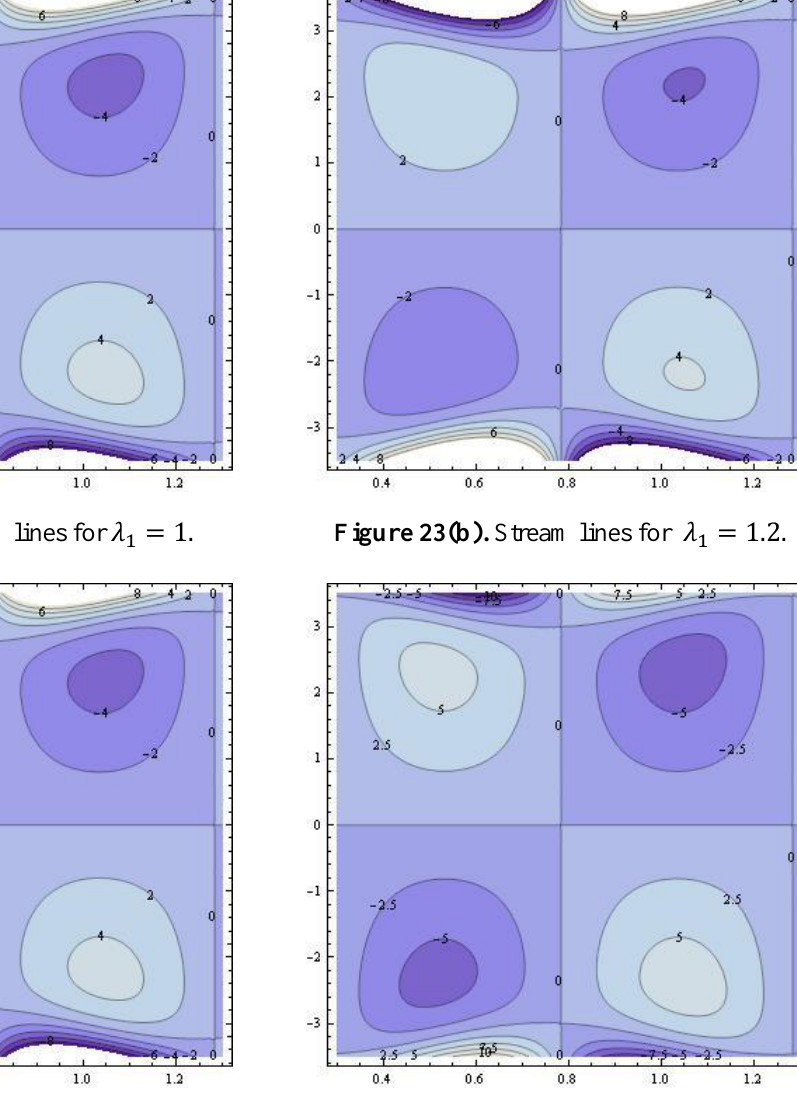
Figure 24(a). Stream lines for 𝐷𝑎 = 0.5. Figure 24(b). Stream lines for 𝐷𝑎 =